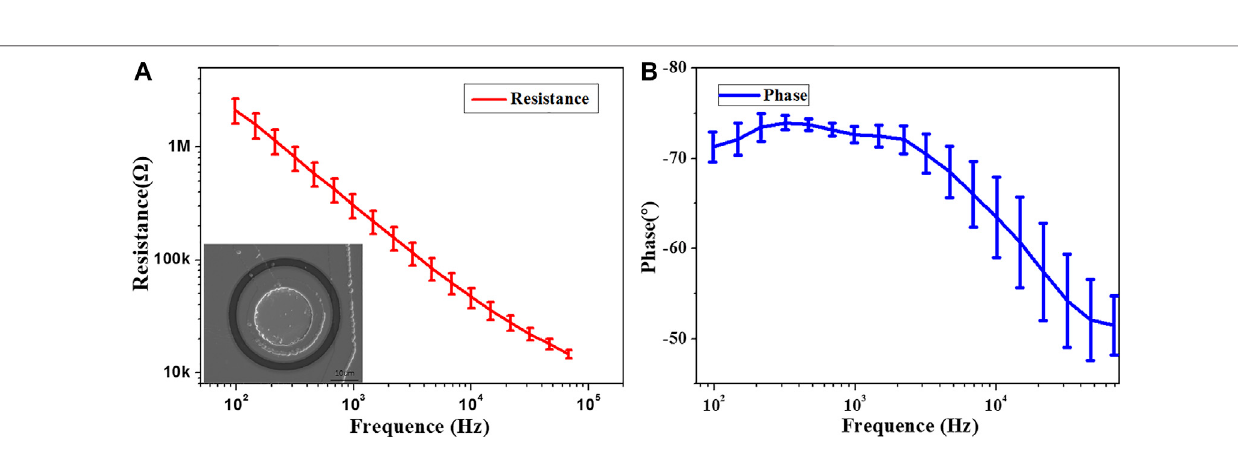
Frontiers in Nanotechnology |